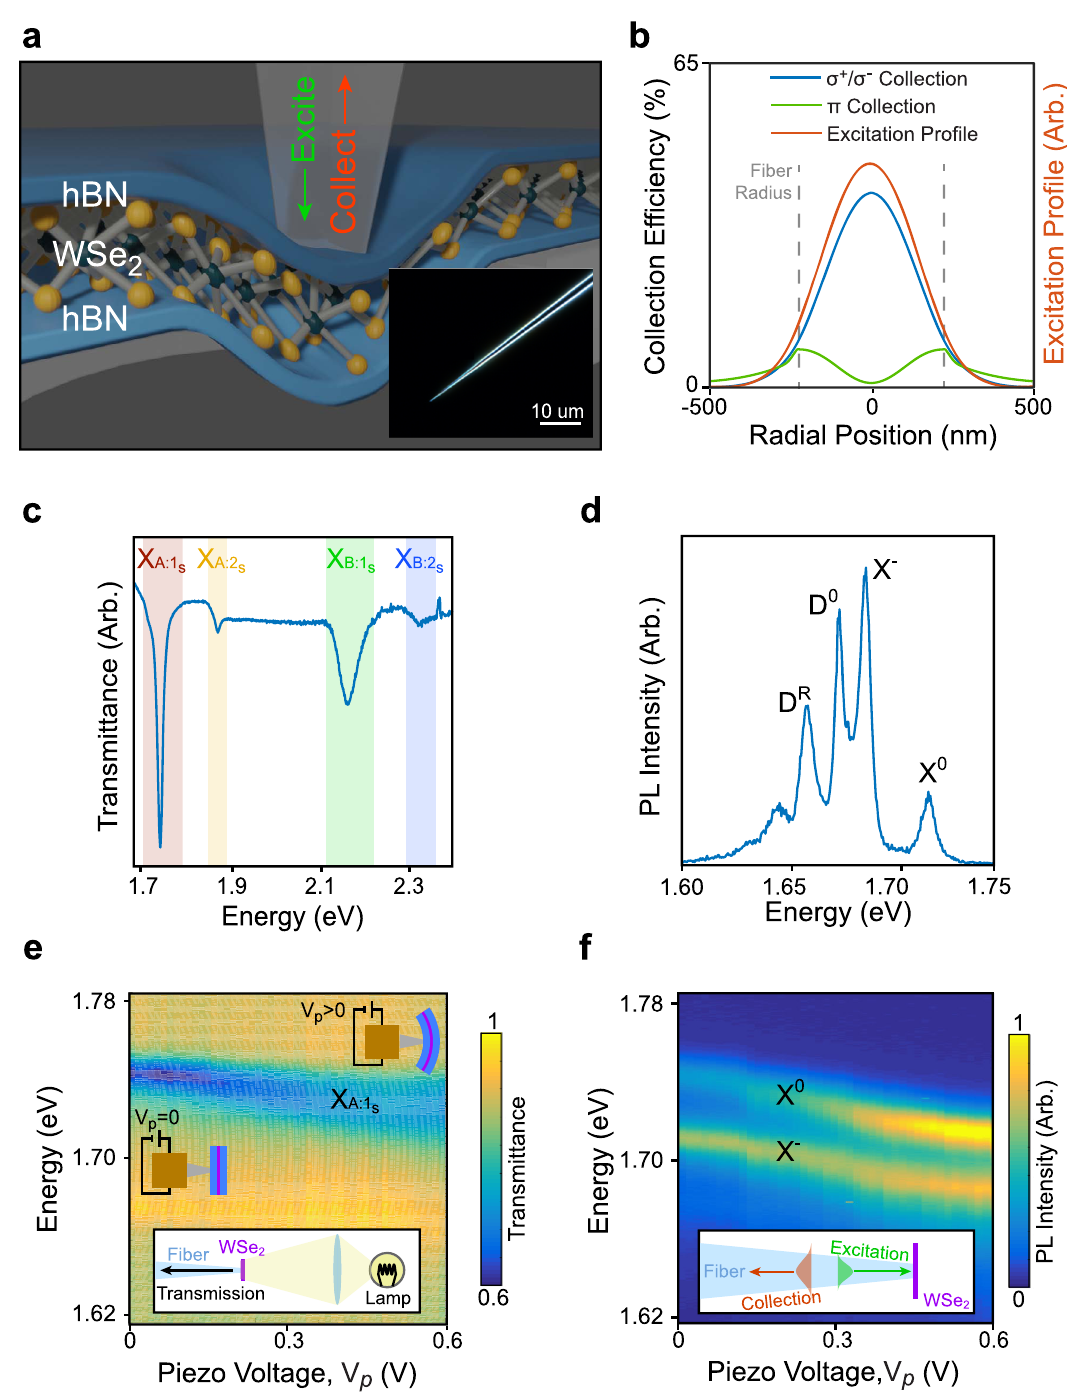
Fig. 1 A cryogenic, fi ber-based technique for strain-dependent spectroscopy. a A schematic of the fi ber interfacing with an hBN/WSe 2 /hBN heterostructure. The fi ber is mounted on a piezoelectric nanopositioner (not pictured). Inset: Dark fi eld optical micrograph of a 240 nm radius tapered fi ber. b We simulate excitation and collection pro fi les (for both circularly polarized ( σ + / σ − ) and z -polarized ( π ) light, for z axis normal to the WSe 2 ) for a 240 nm radius fi ber tip and 700 nm light. c White light transmitted through the device in a cryogenic environment ( T = 5 K) and collected by the fi ber (depicted schematically in inset) shows four transmittance dips. They correspond to the A and B excitons (X A:1s , X B:1s ) and their fi rst excited Rydberg states (X A:2s , X B:2s ). d Fiber-collected PL at 5 K shows four pronounced features originating from (in decreasing energy) the neutral exciton (X 0 ), the charged exciton (X − ), the dark exciton (D 0 ), and the dark exciton ’ s phonon replica (D R ). e As we push the device with the fi ber by increasing the piezo-positioner voltage ( V p ), we observe a decrease in the energy of the X A:1s transmittance dip with increased fi ber displacement. f Likewise, for the same fi ber displacement as in e , we observe decreases in the energy of the X 0 and X − in PL. Data in c , d come from device D1 , while data in e , f come from D2 . D1 and D2 vary only by few-nm differences in hBN thicknesses.